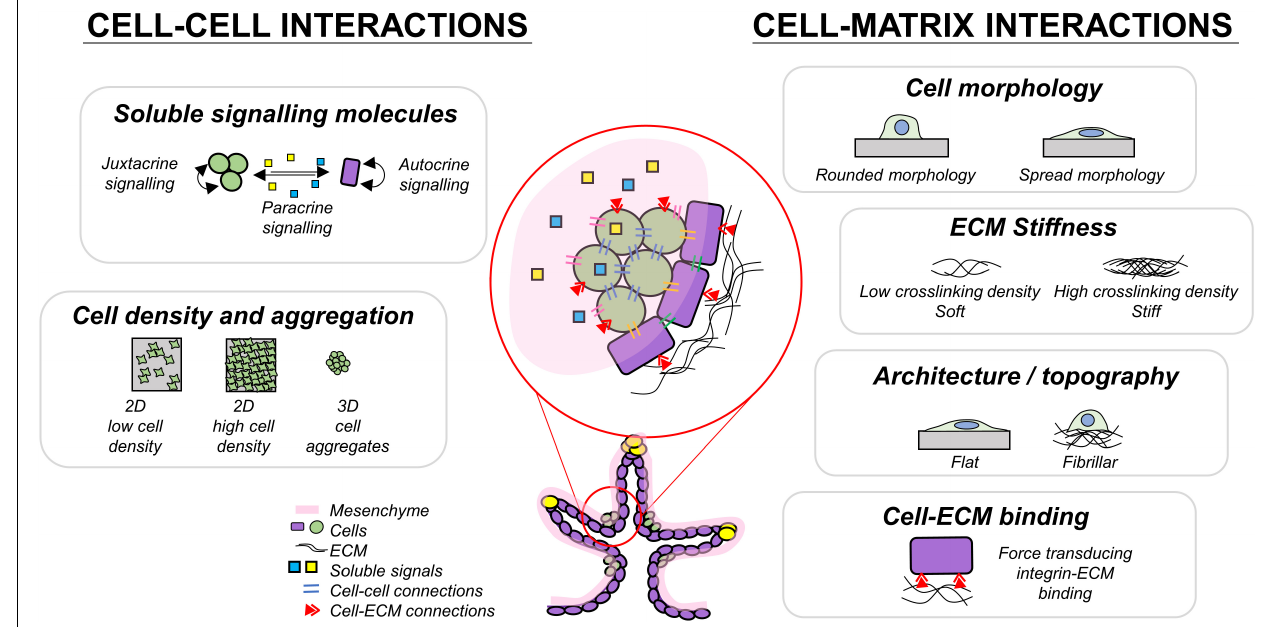
FIGURE 2 | Summary of some cell interactions present during pancreas development which may play a role in guiding endocrine